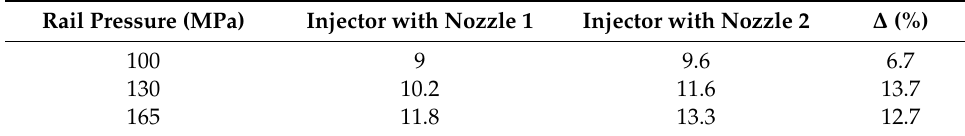
Table 4. Volumetric fuel supplied by electromagnetic injector for 30 injections (ml).